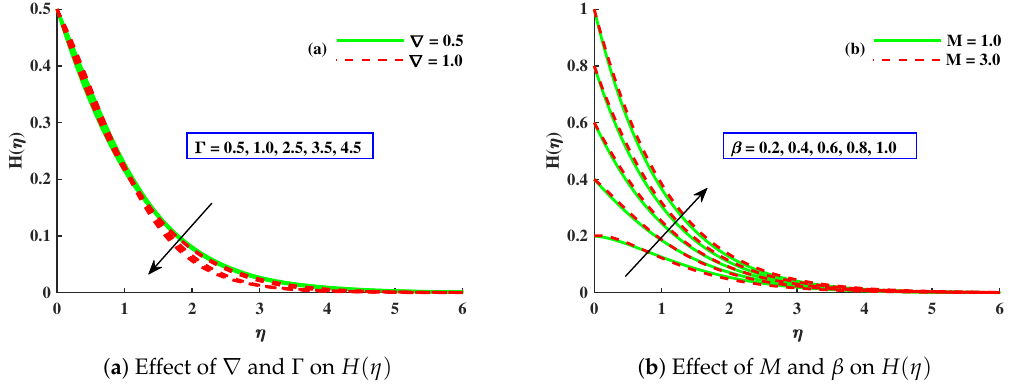
Figure 5. Curves of H ( η ) along ∇ , Γ , M , and β .